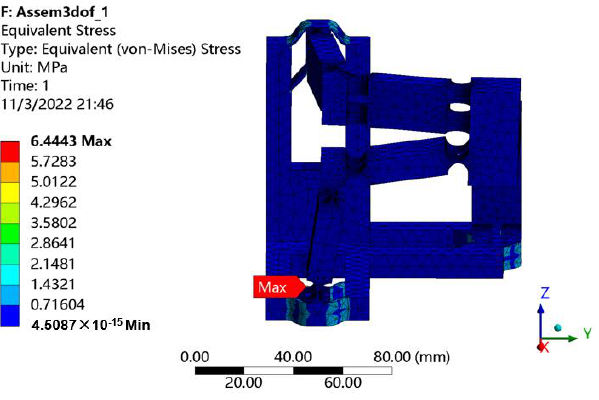
Figure 11. Stress